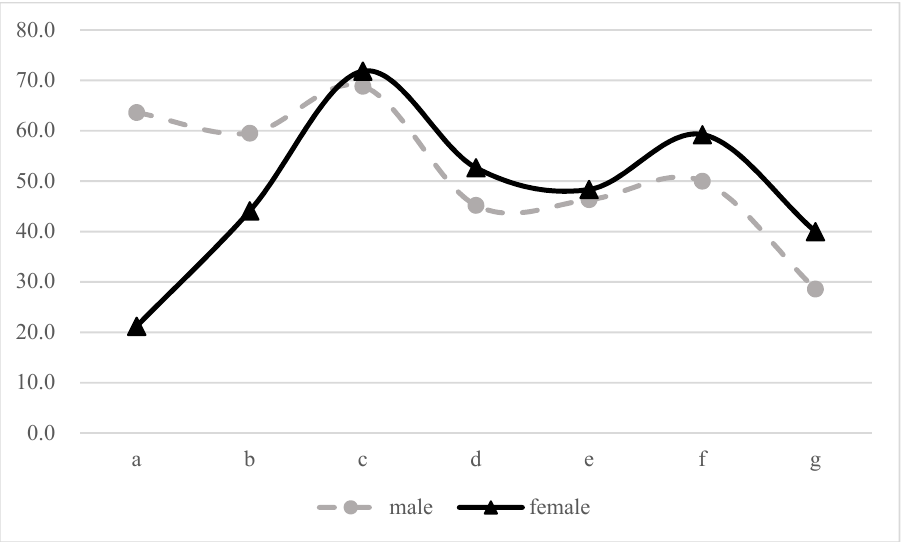
Figure 1. Proportion of homogamy in male and female at different levels of education (%)(N = 127,829). a. Illiterate,